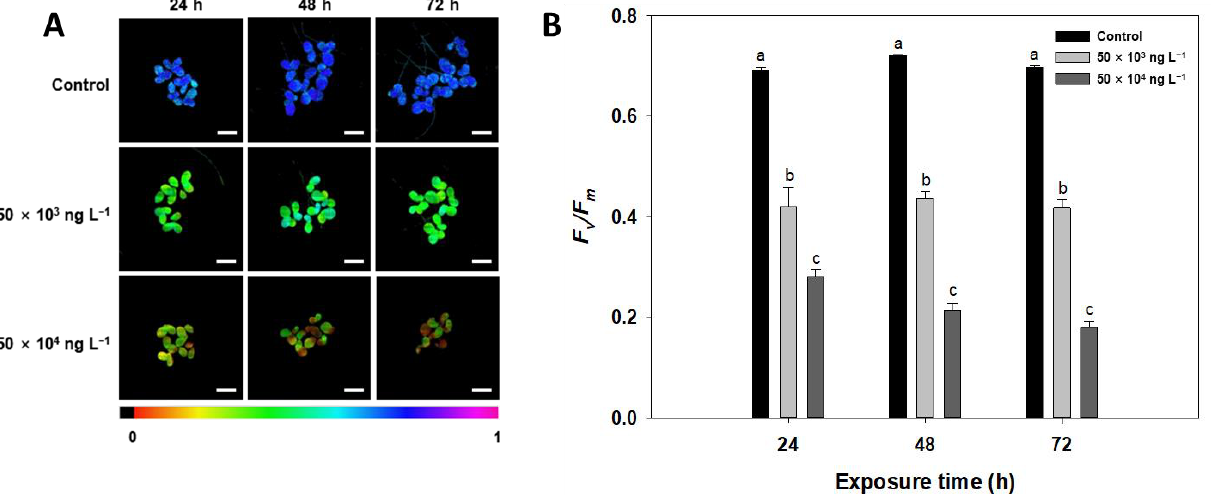
Figure 3. Effects of diuron (50 × 10 3 and 50 × 10 4 ng L −1 ) on maximum quantum yield ( F v /F m ). ( A ) Images of the chlorophyll a fluorescence parameter F v /F m in L. minor under diuron stress. Chlorophyll fluorescence images were obtained using Imaging PAM (I-PAM, Walz, Effeltrich, Germany). ( B ) The average values of F v /F m in L. minor . Values are mean ± standard deviation (n = 3). Different letters indicate statistically significant differences at p < 0.05. Scale bar, 5 mm.